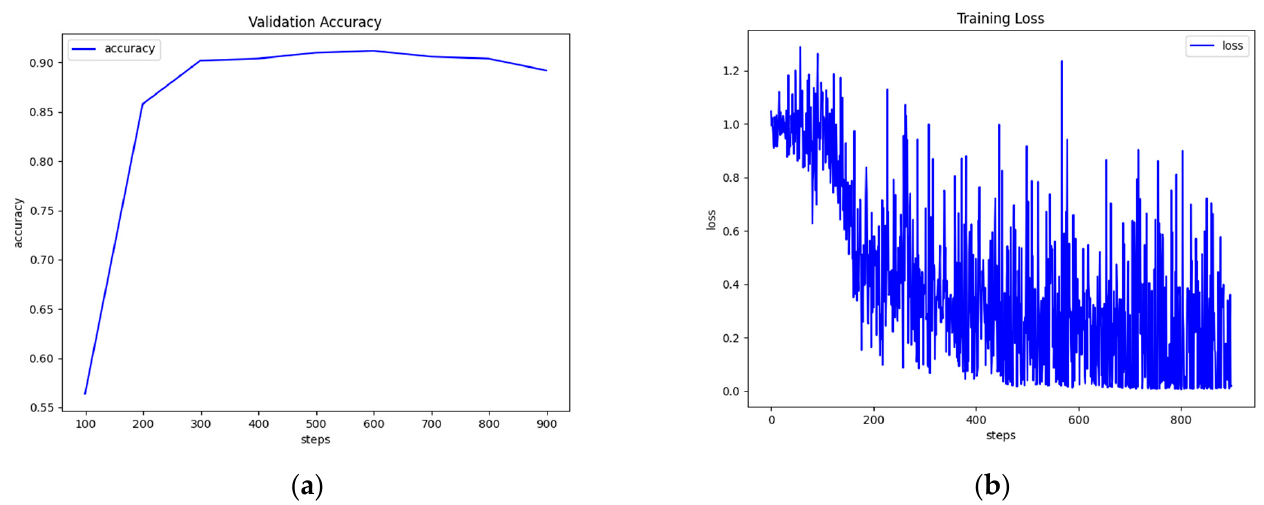
Figure 2. ( a ) Validation accuracy graph and ( b ) training loss graph of best model (RoBERTa-Large) for SICK.